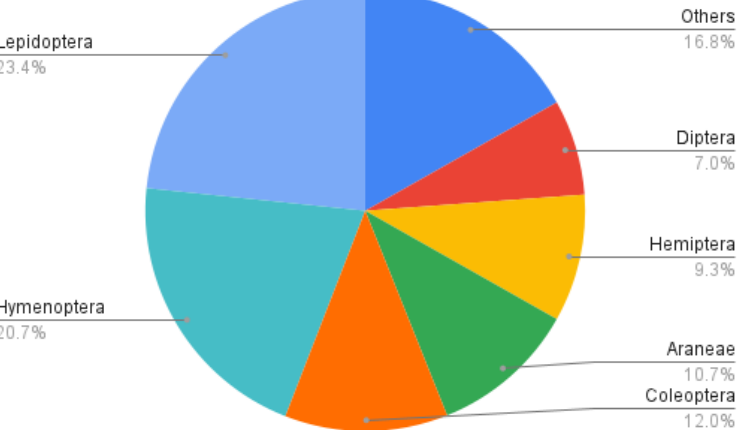
Figure 3. Order-level taxonomic distribution of general information requests received by the